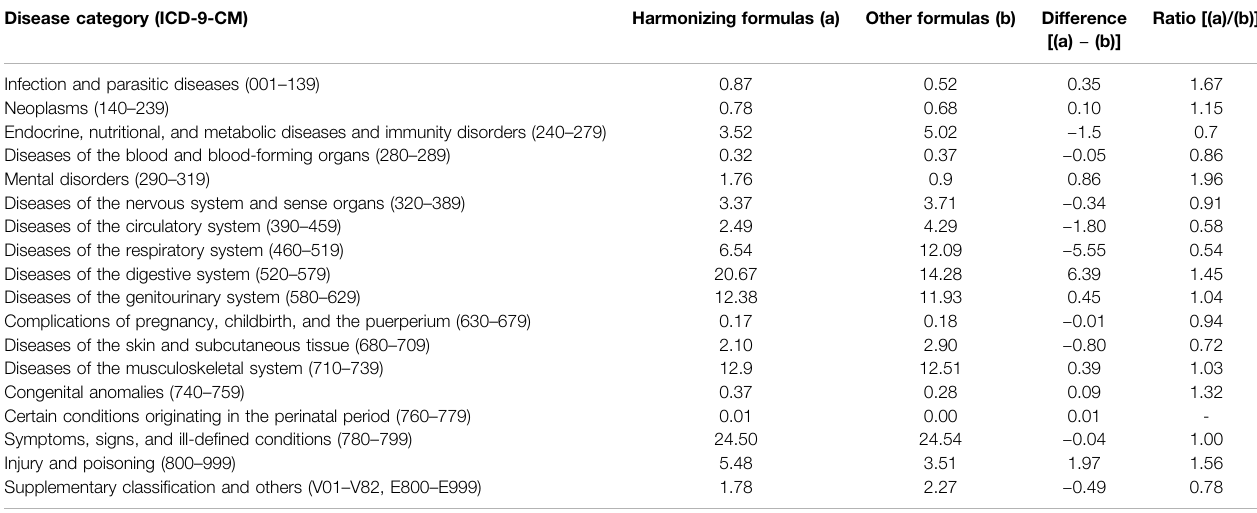
TABLE 2 | Systematic diseases and related health problems for harmonizing formula prescription claims. Disease category (ICD-9-CM)